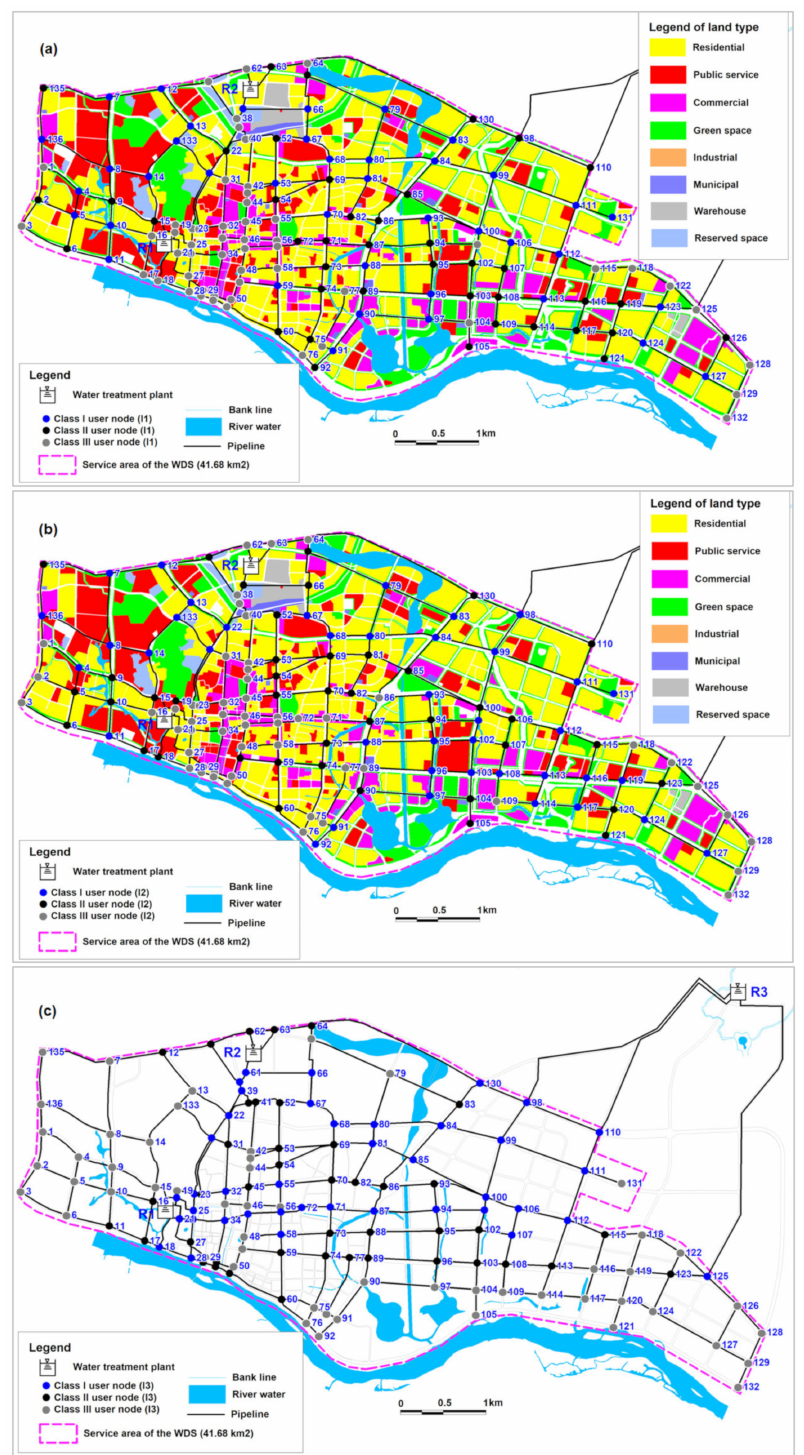
Figure 12. Importance classification of user nodes by the three main indices. ( a ) Daily service ( I 1